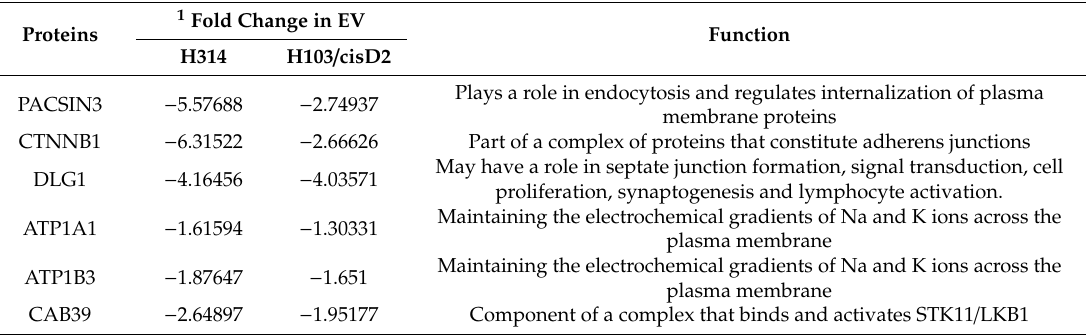
Table 3. Fold changes of EV proteins involved in regulation of metal ion transportation (GO).